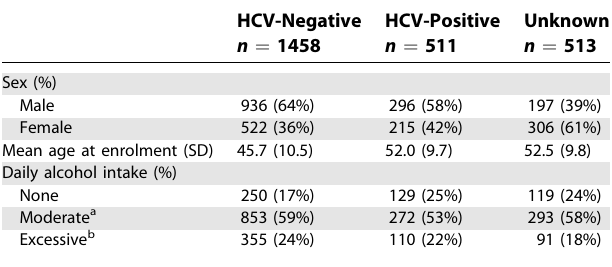
Table adapted from Osella et al.